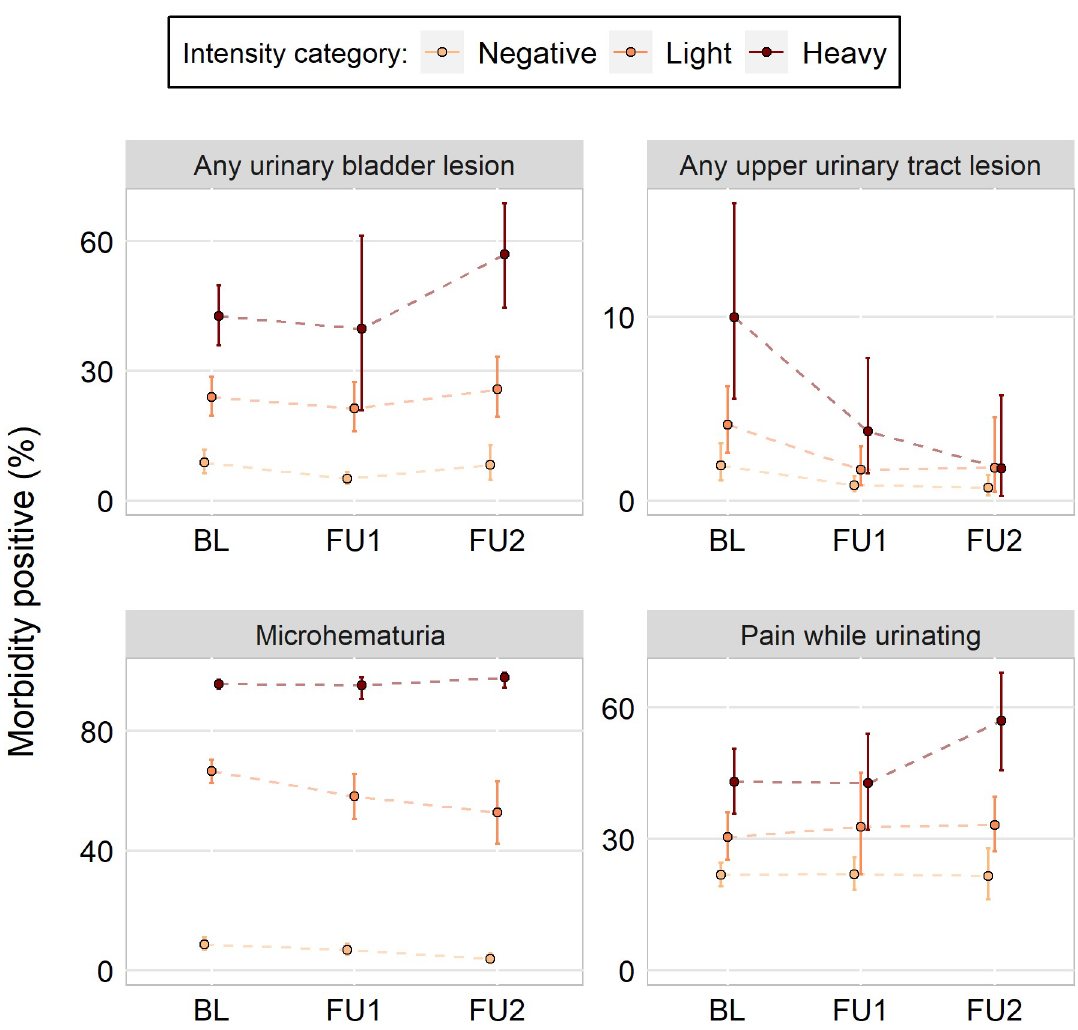
Fig 2. Line graphs of Schistosoma haematobium -related morbidity percentages, broken down by intensity category, across three surveys (baseline, BL; follow-up 1, FU1; follow-up 2, FU2). Participants were enrolled between 2003 and 2008 in Mali, Niger, and Tanzania. Clustering by school accounted for in 95% confidence bands. Infections were assessed by urine filtration.